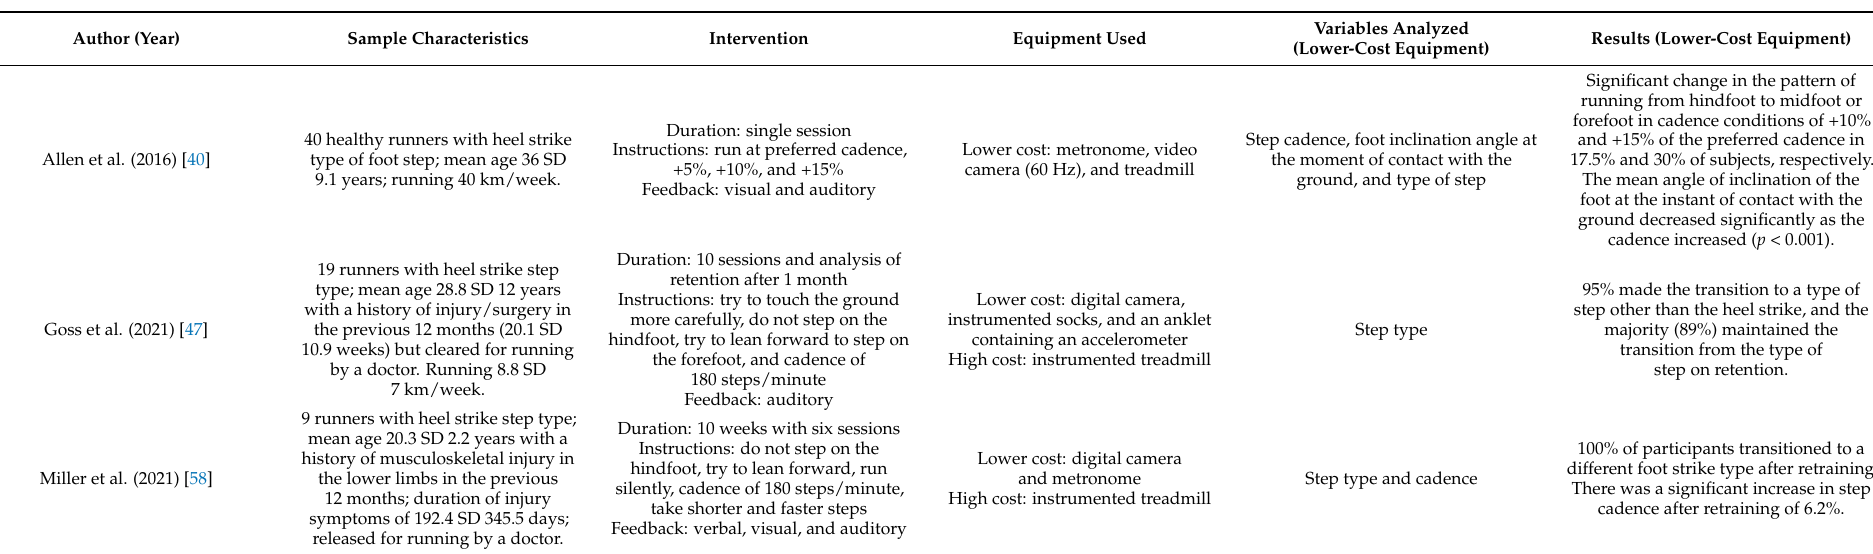
Table 3. Summary of experimental studies that analyzed spatiotemporal variables, kinetics, and foot kinematics as a retraining strategy without the use of a control/comparative